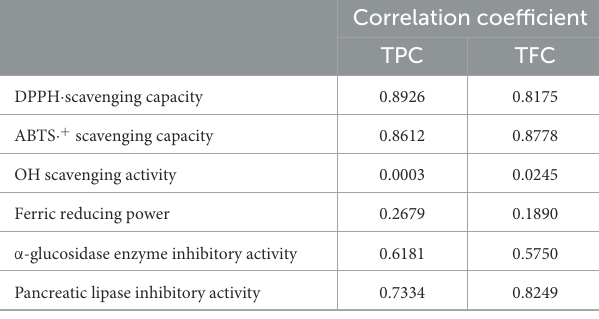
TABLE 5 A correlation between biochemical composition and bioactivities.